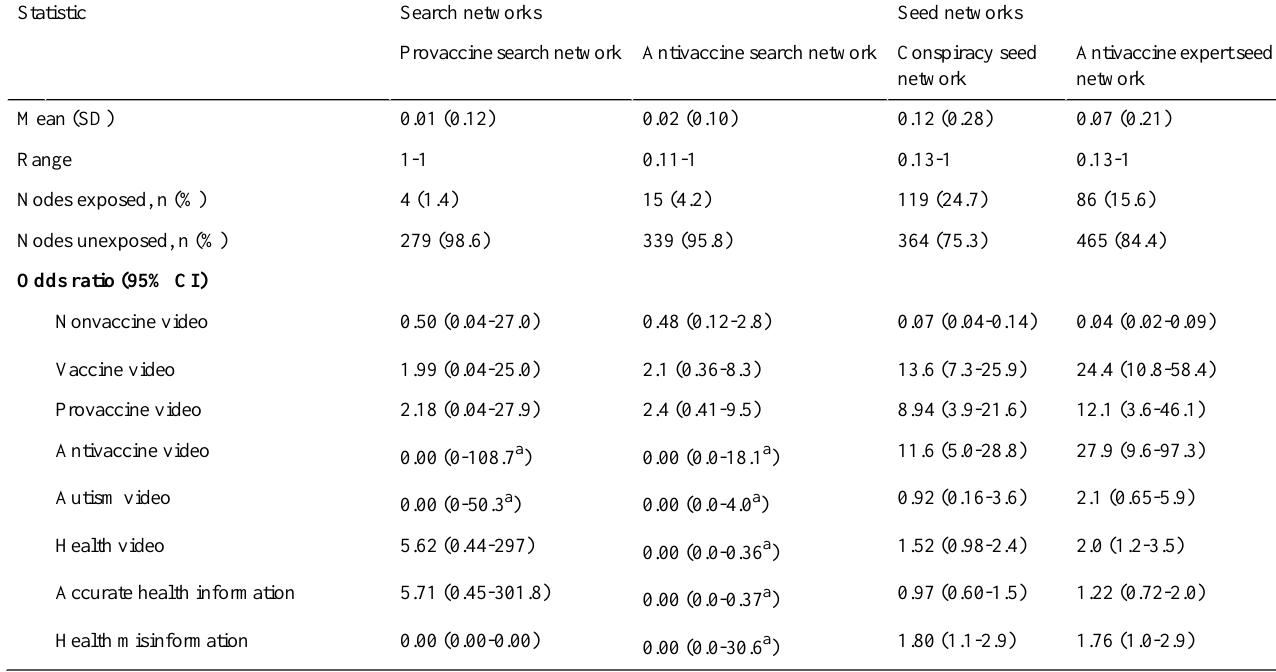
Table 2. Descriptive statistics of the exposure to antivaccine video